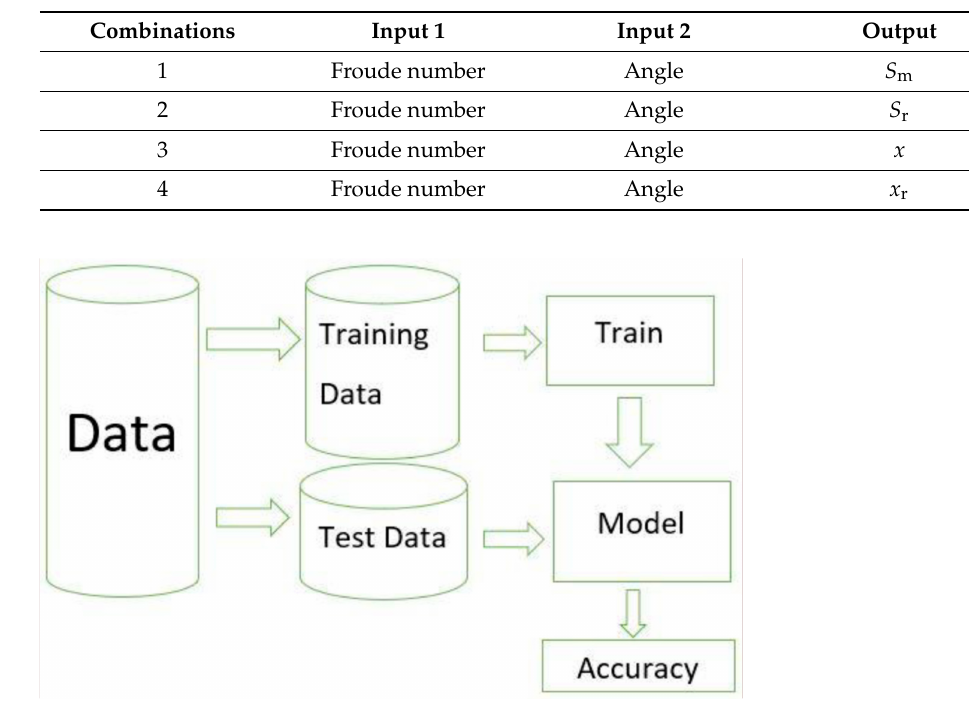
Figure 2. Training data and